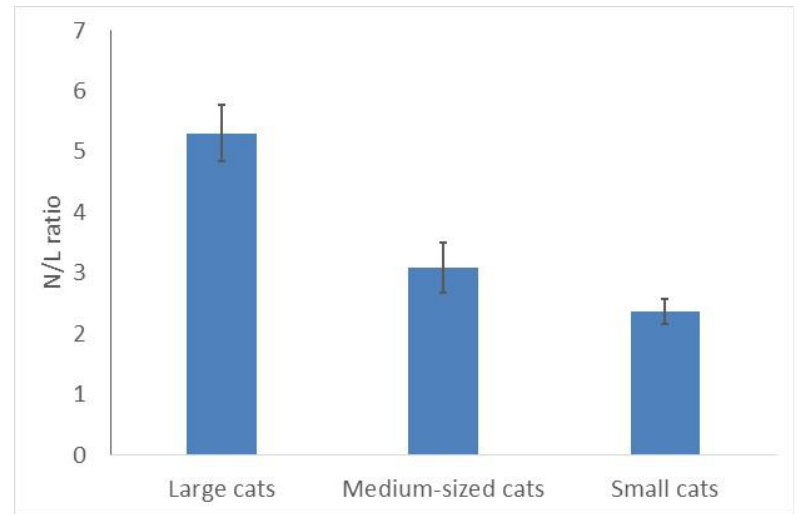
Figure 4. Mean neutrophils/lymphocytes ratio is higher in larger cats than in smaller felids.